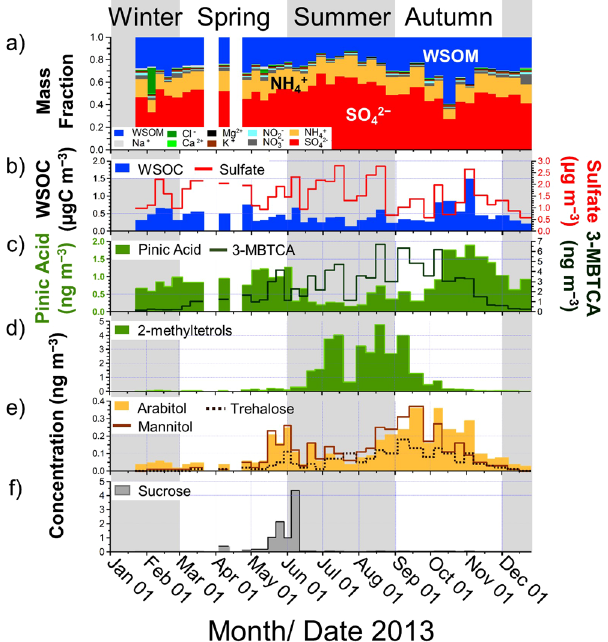
Figure 2. Time series of (a) the mass fraction of the chemical components in water-soluble aerosols, the mass concentrations of (b) WSOC and sulfate, (c) pinic acid and 3-methyl-1,2,3-butanetricarboxylic acid (3- MBTCA), (d) 2-methyltetrols, (e) arabitol, trehalose, and mannitol, and (f) sucrose for the year 2013. Each season is categorized by shaded areas.